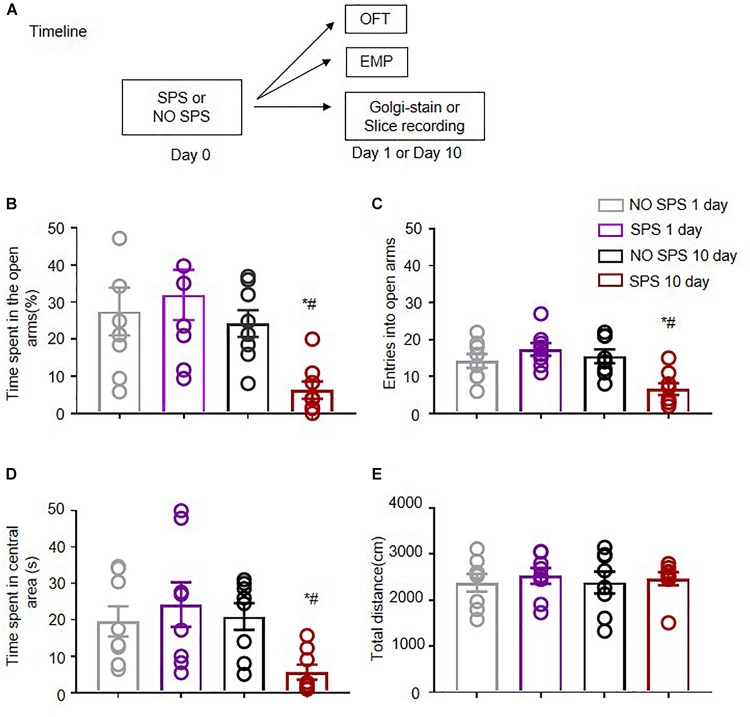
Effect of single prolonged stress (SPS) on anxiety-like behaviors on the first and tenth day after stress. (A) Experimental procedures. (B,C) Time spent in open arms (B) and the entries into open arms (C) in different experimental conditions in EPM. (D,E) Time spent in the central area (D) and total distance (cm) (E) in different experimental conditions in OFT. n = 8 per experimental condition. #Different from SPS(1d) group, ∗Different from NO SPS group at each post-stress day, ∗
#p < 0.05, two-way ANOVA. Data are shown as means ± SEM.